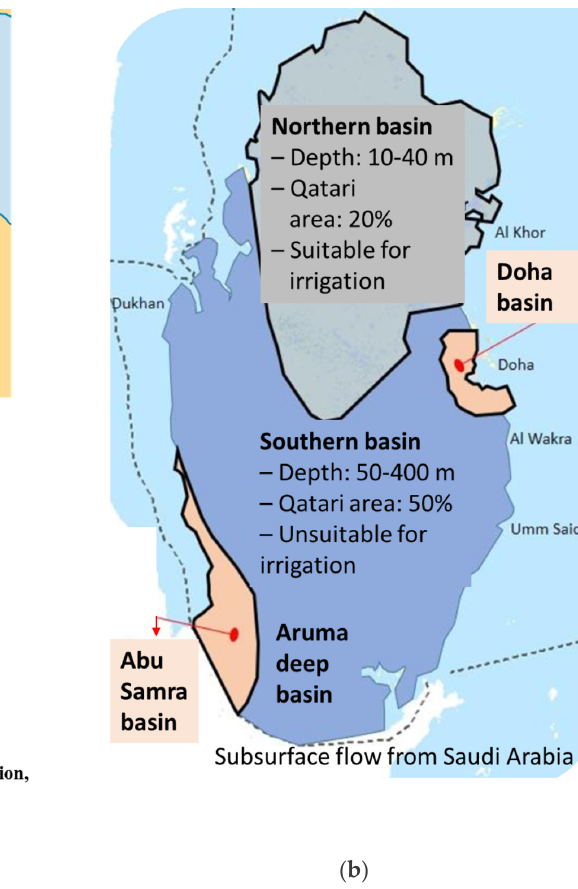
Figure 2. ( a ) The geo-referenced map of Qatar showing its location on the globe (the inset), in the Persian Gulf, and on the only land border of Saudi Arabia; ( b ) characteristics of five groundwater basins of Qatar [38]; and ( c ) the country’s reliance on desalination, groundwater, and treated sewage effluent [39].